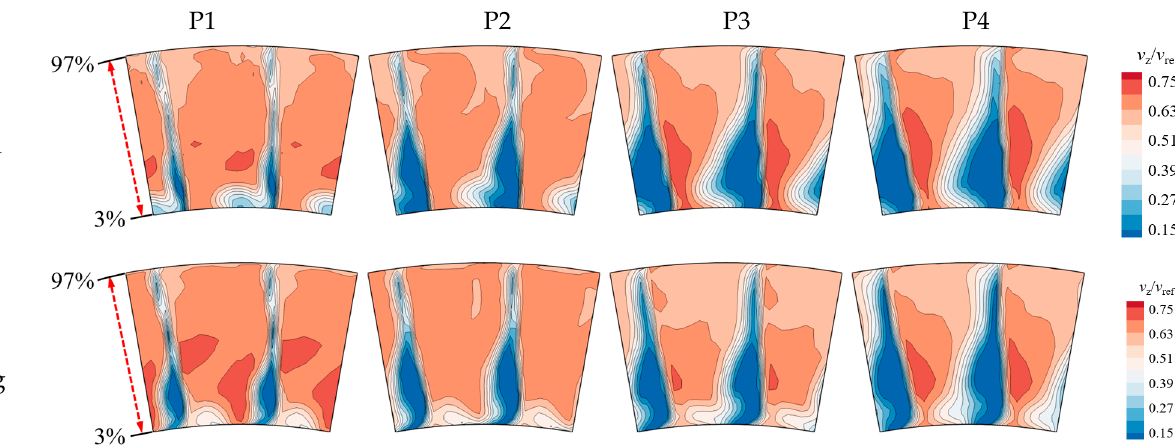
Figure 36. The distribution of the normalized axial speed at the stator outlet.